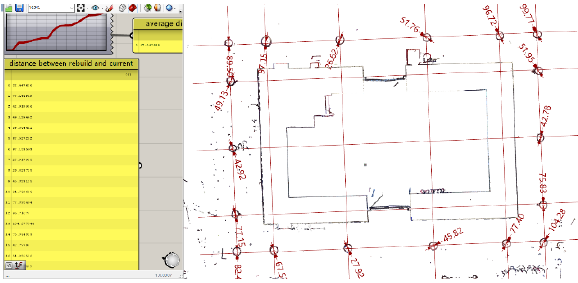
Figure 13. the grid system of the first floor